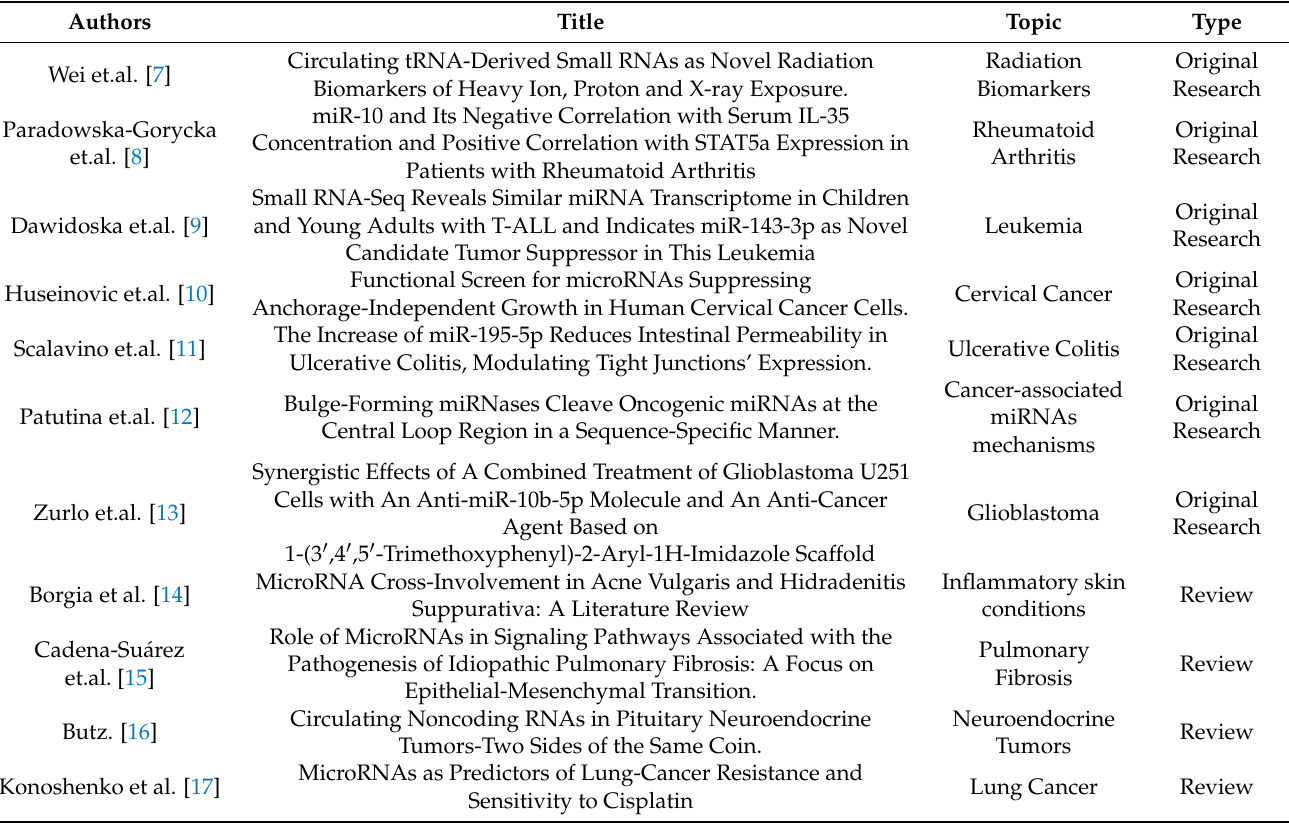
Table 1. Contributors to the Special